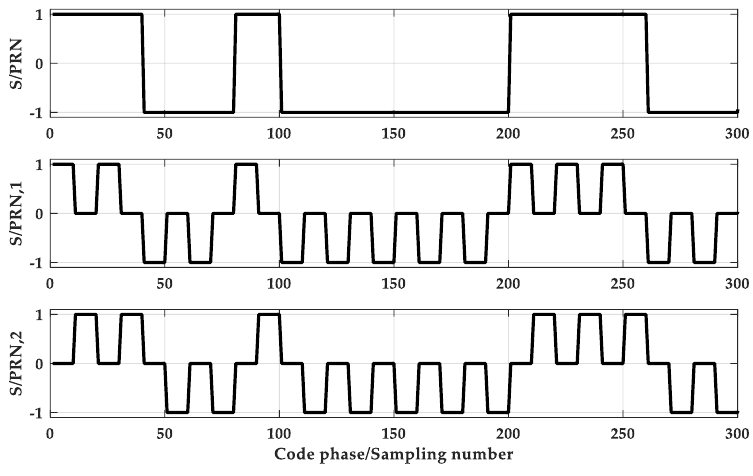
Figure 5. The Separation of PRN at M = 2.